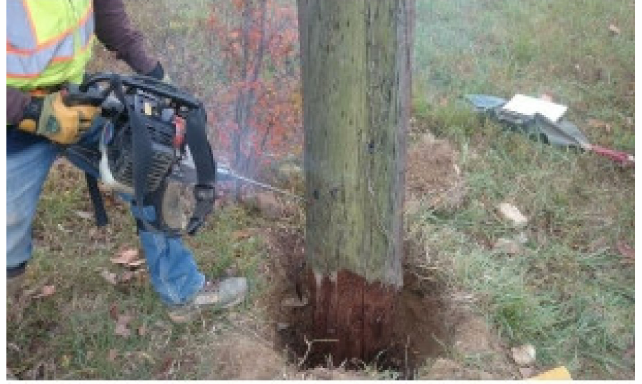
Figure 2. Conventional wooden utility pole inspection